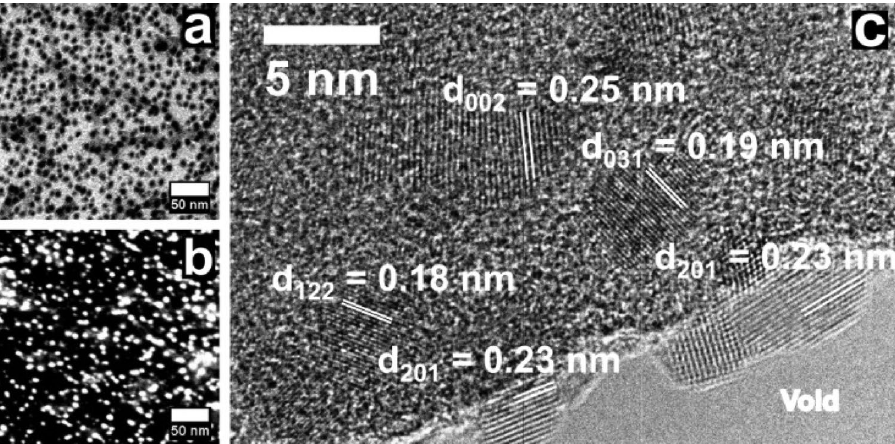
Figure 2. ( a ) ABF-STEM, ( b ) HAADF-STEM and ( c ) HRTEM micrographs of ZnSiN 2 nanostructures with their respective lattice spacing in its orthorhombic phase.